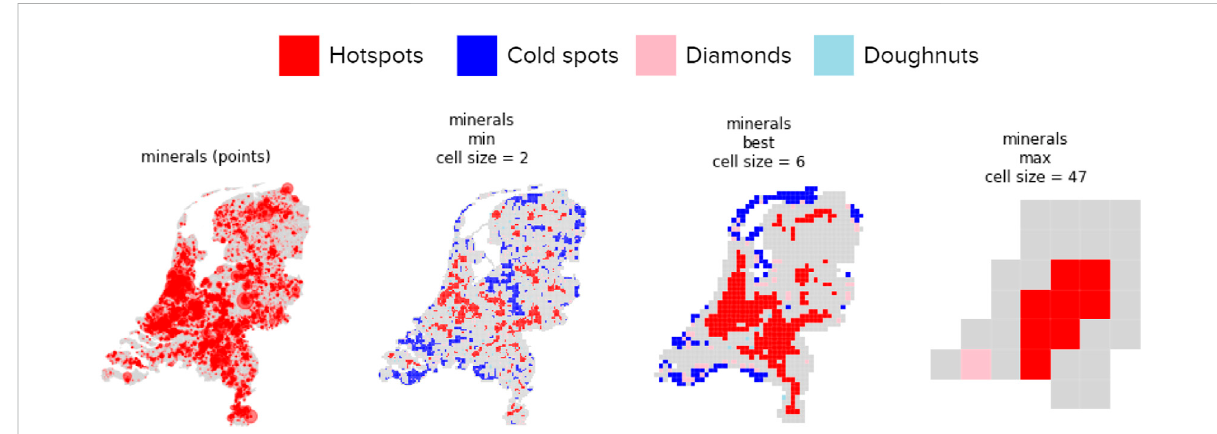
FIGURE 9 Mapsofhotspots(red),coldspots(blue),doughnuts(lightblue),anddiamonds(pink)ofmineralreuseintheNetherlands.Forhotspotmapsofall material types, please refer to the Supplementary Materials. Maps created by authors.